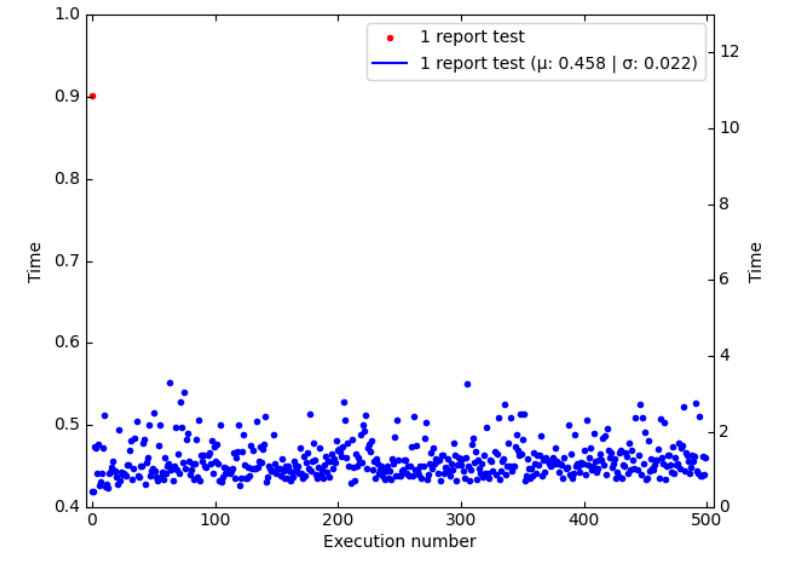
Figure 3. Time required to store a